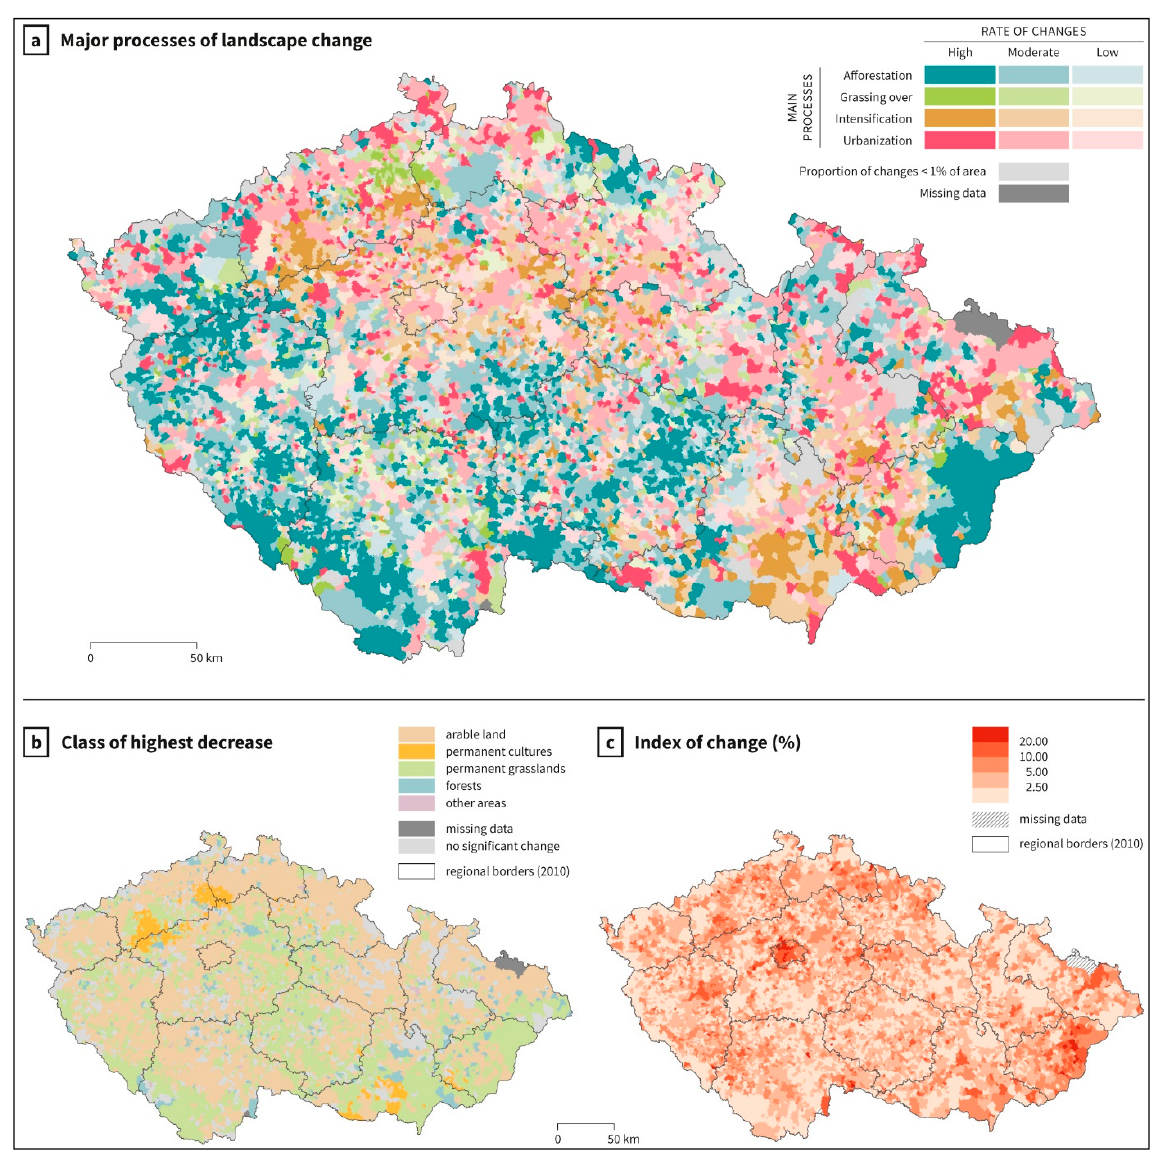
Figure 3. Major processes and intensity of landscape change between 1896 and